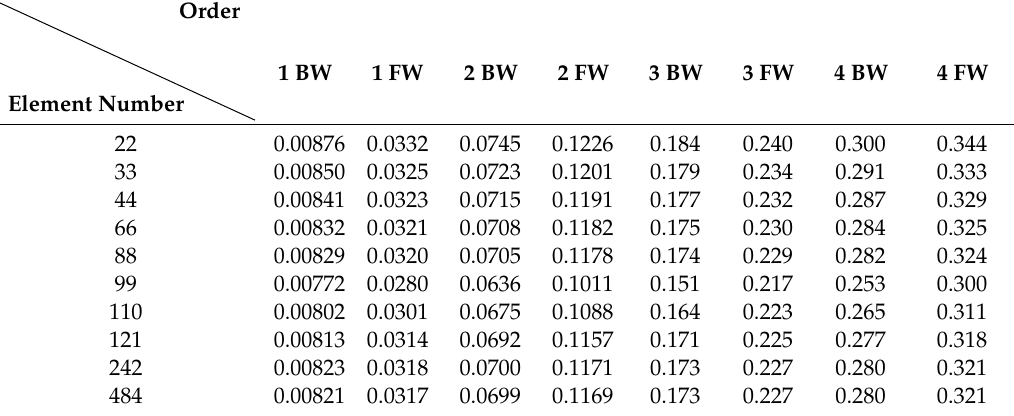
Table 14. Natural frequencies via spatial discretization ( h = 500 Nms).